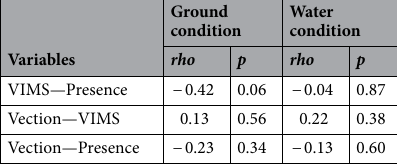
Table 2. Correlation coefficients (rho) and associated p values for comparisons between VIMS, presence and vection.